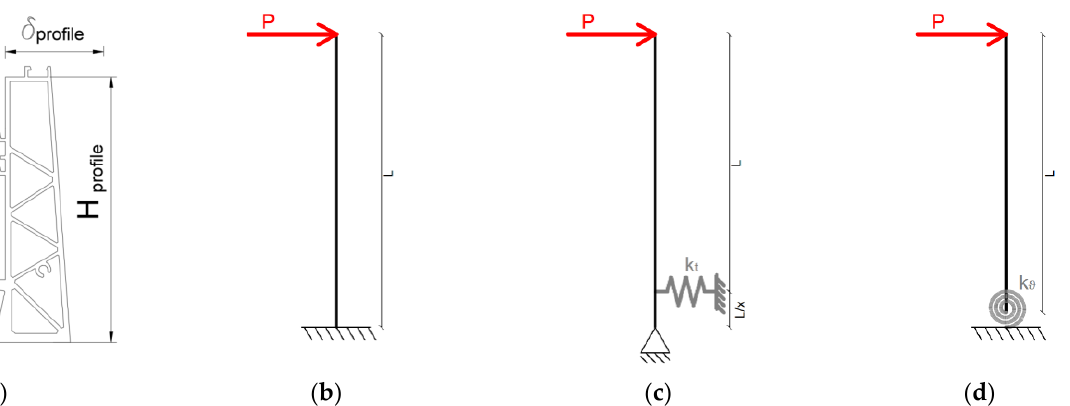
Figure 2. Schematic representation of possible mechanical models for a glass balustrade with a linear restraint at its base: ( a ) example of a metal restraint (cross-section); ( b ) cantilever mechanical model with an ideally rigid clamp restraint; or ( c , d ) mechanical models inclusive of equivalent springs to reproduce the real boundaries.